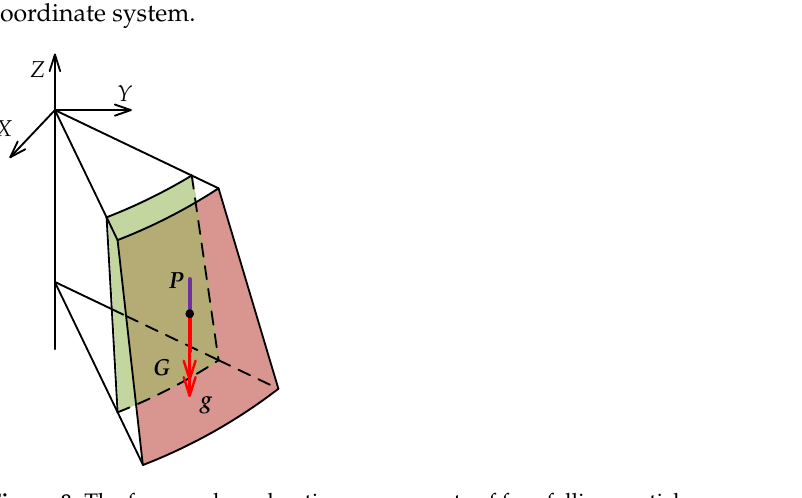
fore, the coordinates of the contact point are determined by the free-falling time of the particle P . The contact point is the endpoint of the free-falling of the particle P and the point of the mantle surface, which can be solved by Equation (33). 0 0 42 0